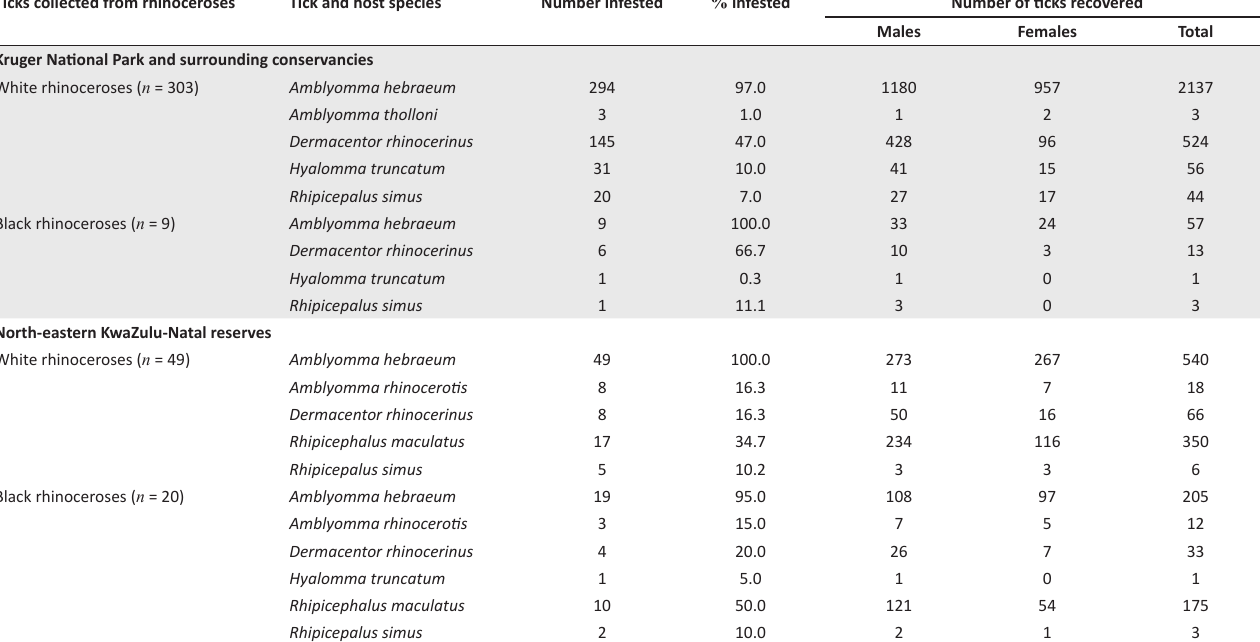
TABLE 2: Ixodid ticks collected from rhinoceroses in the Kruger National Park and surrounding conservancies, and in the north-eastern KwaZulu-Natal reserves. Ticks collected from rhinoceroses Tick and host species Kruger National Park and surrounding conservancies White rhinoceroses ( n =